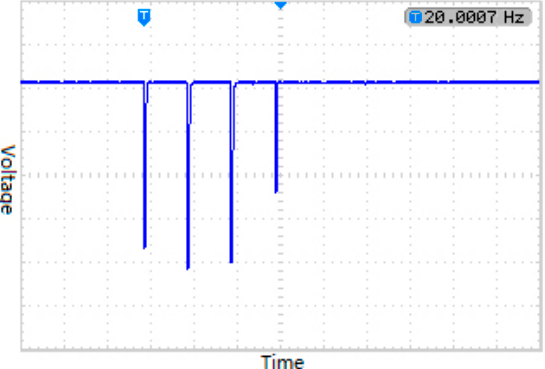
Figure 13. Four-pulse sequences.